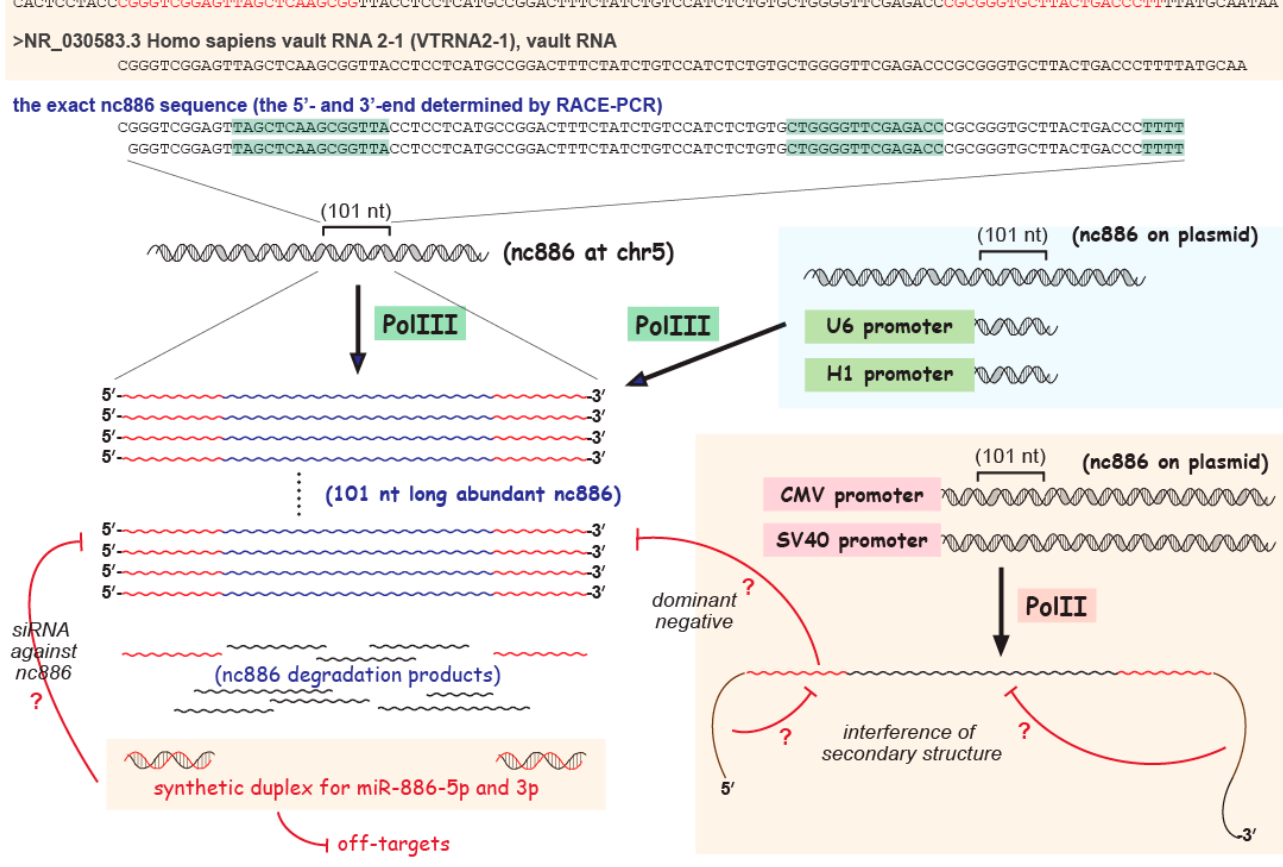
Figure 1. The sequence of nc886 and its natural expression, in comparison to ectopic expression methods. The three sequences on the top are from miRBase (red letters: miR-886-5p and -3p), from the NCBI database, and experimental determination. Pol III promoter and termination elements are highlighted in green shadow. The nc886 RNA is drawn in wavy lines in which red portions designate miR-886-5p and -3p. Improper ectopic expression of nc886 (and its alleged products miR-886-5p and -3p) is illustrated in faint orange boxes. Magenta blunt arrows with a question mark indicate potential side effects of illegitimate expression. See the main text for